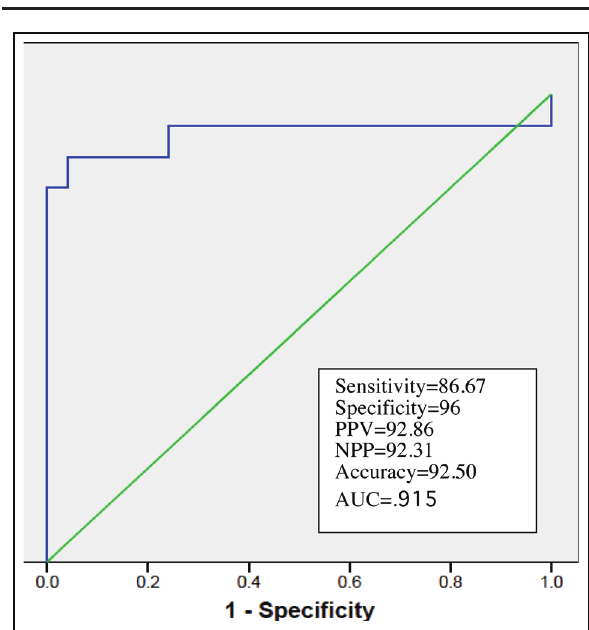
Receiver operating characteristic (ROC) curves of oxygen desatura- tion index (ODI) parameters for the diagnosis of severe obstructive sleep apnea (OSA) patients with thresholds apnea hypopnea index (AHI) > 30.